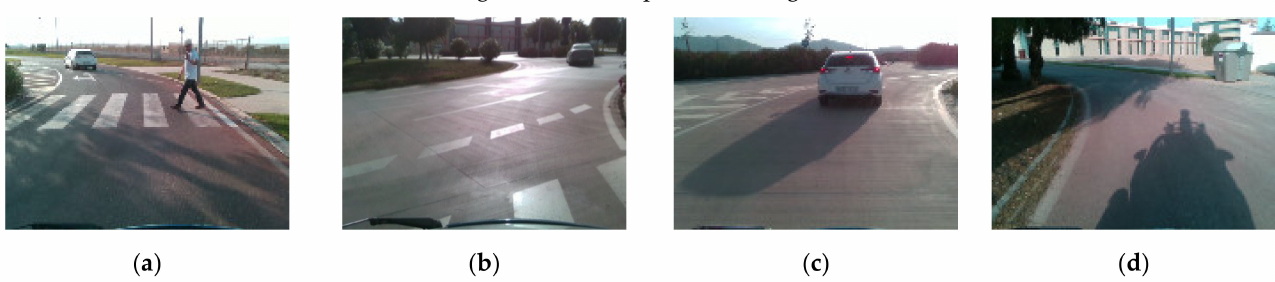
Figure 3. Images from dataset. ( a ) pedestrian crossing; ( b ) saturation of the illumination on roundabout; ( c ) car braking; ( d ) complex shadows on the